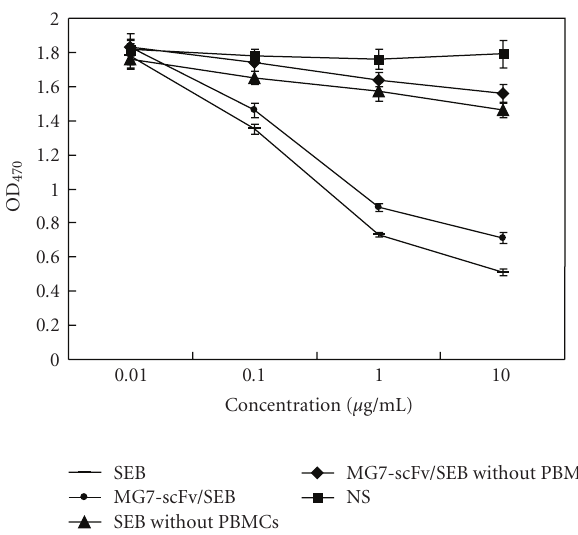
Figure 4: The e ff ect of MG7-scFv/SEB fusion protein on SGC- 7901 cell proliferation was detected by CCK-8 assay. When co- cultured with e ff ector cell PBMCs, both SEB and MG7-scFv/SEB could e ff ectively inhibit the proliferation of SGC-7901 cell ( P < . 05).